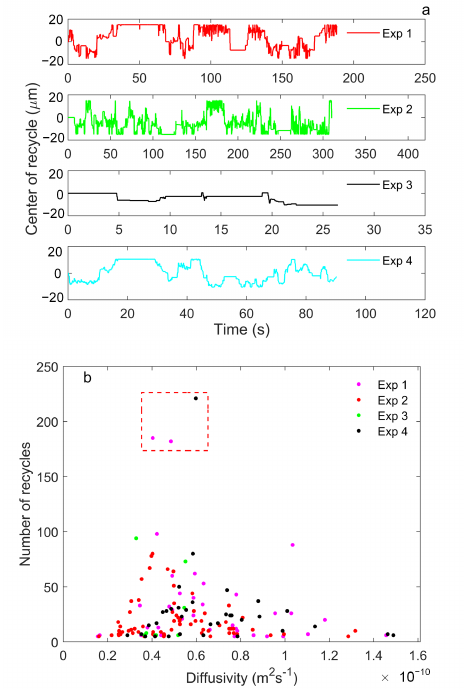
Figure 8. Results from SMR in the capillary microchannel with the piezo stage. ( a ) The variations of centers of recycles in 4 experiments. In each experiment, multiple molecules come into recycling and the periods without fluctuations represent the piezo stage stops and waits for the next molecule to be recycled. The maximum number of recycles is above 200, which is equivalent to longer than 6 s. ( b ) The estimated diffusivities of individual FLuospheres, which forms a Gaussian distribution centered around 5 × 10 − 11 m 2 s − 1 . The red box highlights the molecules being recycled for about 200